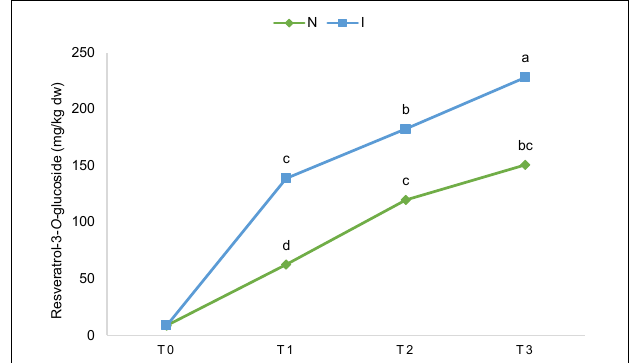
FIGURE 2 | The ascending content of resveratrol-3- O -glucoside throughout the experiment [before inoculation (T 0 ), 24 hpi (T 1 ), 48 hpi (T 2 ), and 96 hpi (T 3 )] for non-inoculated (N) and inoculated (I) samples regardless of the International Organization of Vine and Wine (OIV) class. The values for each time point and treatment were obtained by the mean of the values of 17 genotypes. The differences between the means were evaluated by Duncan’s multiple range test at a confidence level of 95% ( p < 0.05). Different letters show statistical significance.